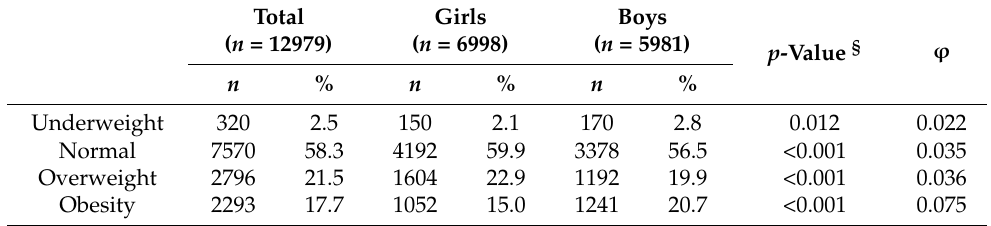
Table 1. Comparison of body mass index categories between girls and boys.